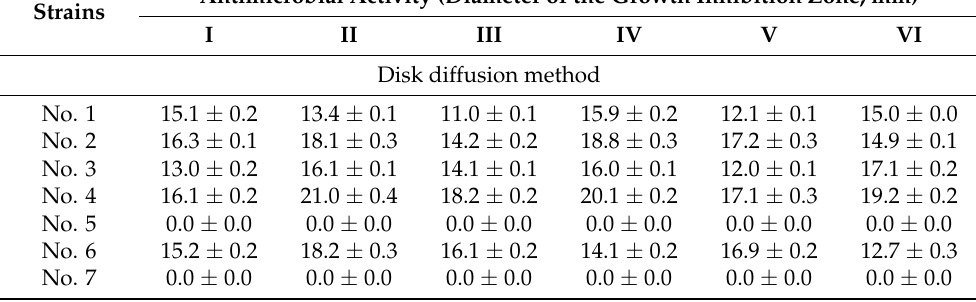
Table 1. The evaluation of the antimicrobial properties of microorganisms isolated from bottom sediments of Baikal